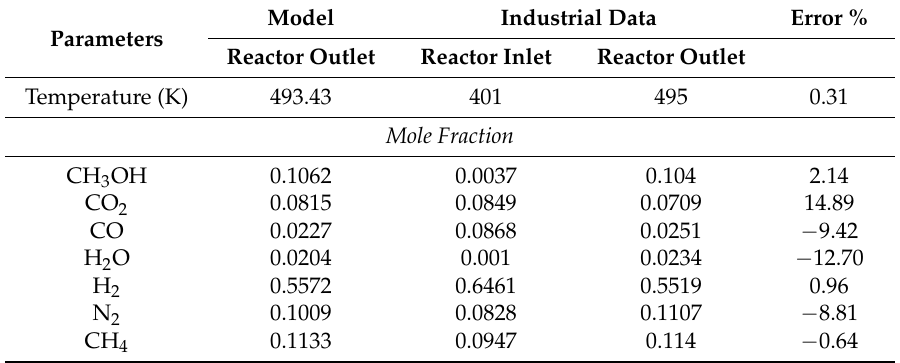
Table 8. Comparison between the outcome of the model and industrial data of CR